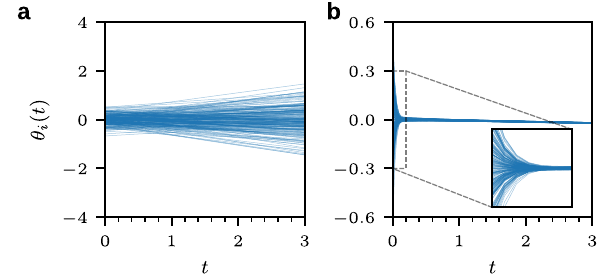
Fig. 3 Synchronization of coupled oscillators. The evolution of oscillator phases θ i ð t Þ (1 ≤ i ≤ N ) in a complete network that consists of N ¼ 225 coupled Kuramoto oscillators [Eqs. (11) and (12)] with a subcritical coupling constant K ¼ 0 : 1 K (cid:1) , which does not lead to synchronicity. All phases are initially distributed according to a normal distribution with mean 0 and standard deviation 0.2. a The control input is set to u i ð t Þ ¼ 1 for all i (uncontrolled dynamics), leading to increasing phase differences over time.